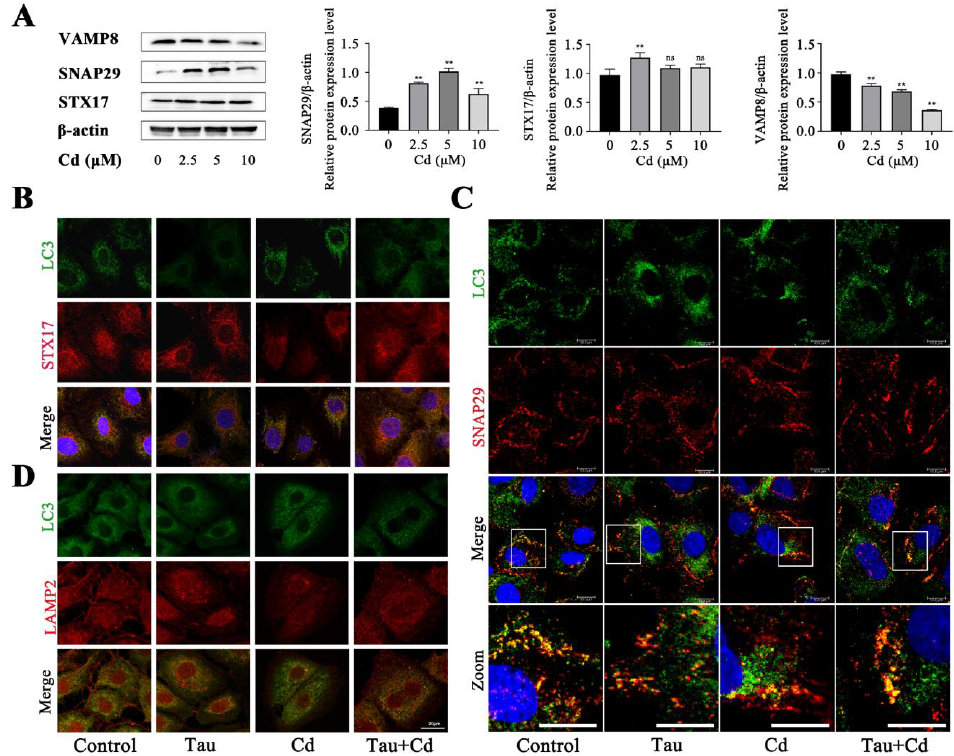
Figure 4. Tau promotes the transfer of STX17 and SNAP29 to autophagosomes and VAMP8 to lysosomes. ( A ) Effects of Cd on the levels of membrane-fusion-associated proteins in BRL3A cells. Cells were treated with varying concentrations of Cd (0, 2.5, 5, and 10 µ M) for 6 h, then the proteins levels of STX17, SNAP29, VAMP8 were analyzed by Western blotting. Compared with the Control group, ns > 0.05, ** p < 0.01. ( B , C ) Effect of Tau and Cd on the co-localization of LC3 with STX17 and SNAP29 in BRL3A cells (scale bar = 20 µ m). ( D ) Effect of Tau and Cd on the co-localization of VAMP8 with LAMP2 in BRL3A cells (scale bar = 20 µ